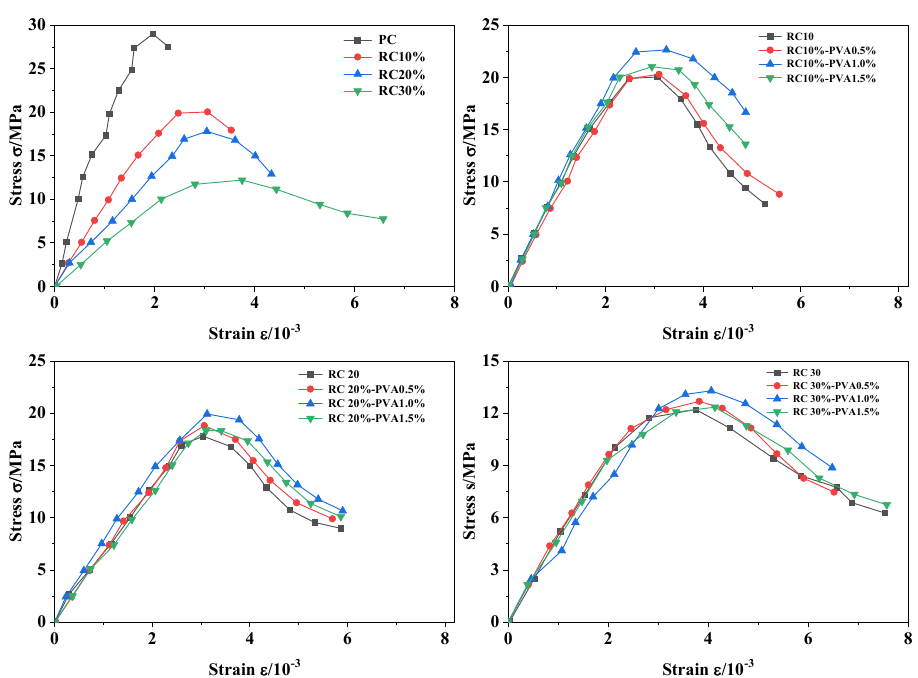
Figure 15. Displacement deformation cloud.